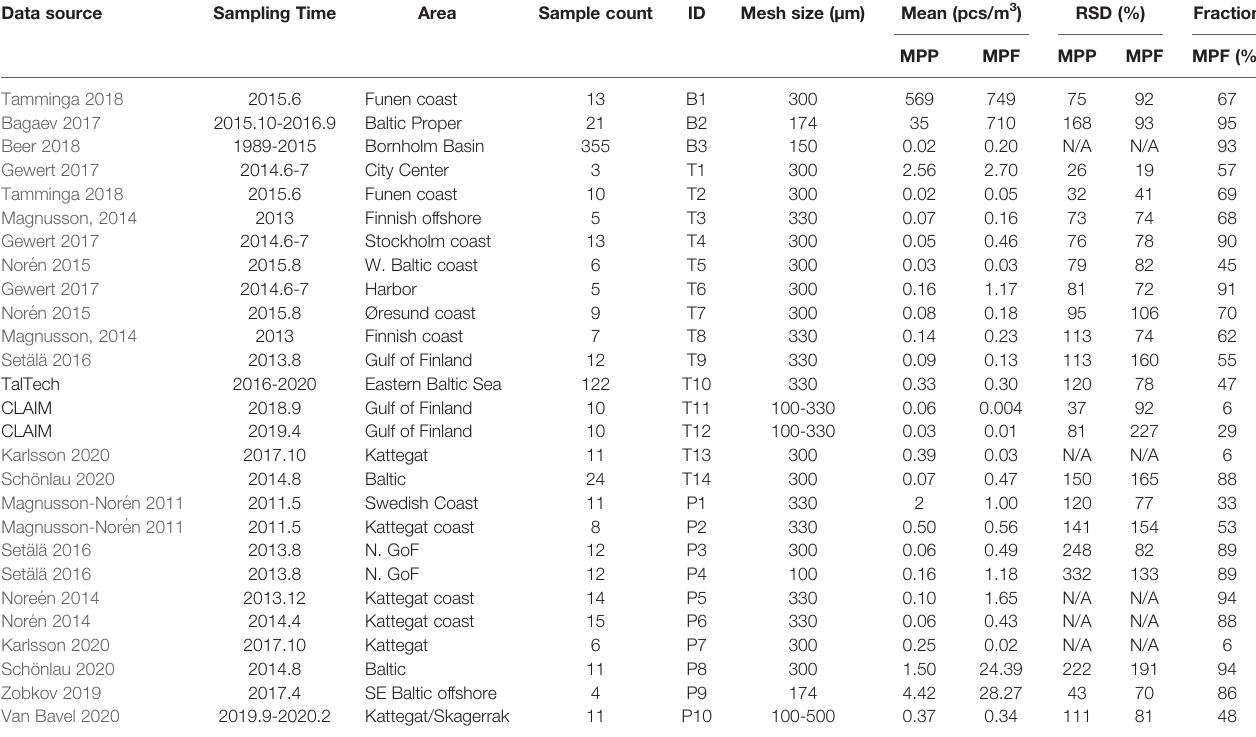
TABLE 2 | Multiple microplastic datasets and statistics. Data